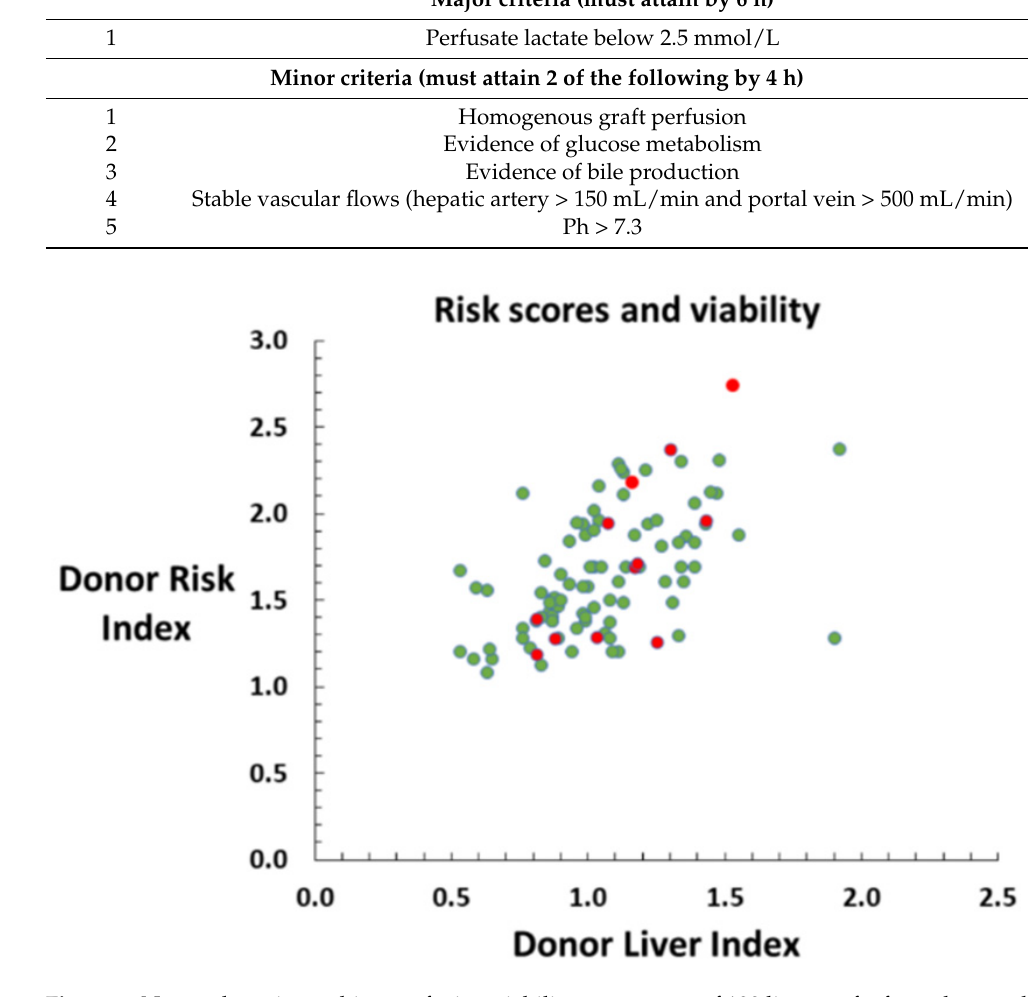
DRI and DLI for viable (green) and non-viable grafts (red). Non-viable grafts are distributed across a brain-dead donors with the intent to transplant. Scatter plot demonstrating relationship between range of donor risk score values, and do not appear to